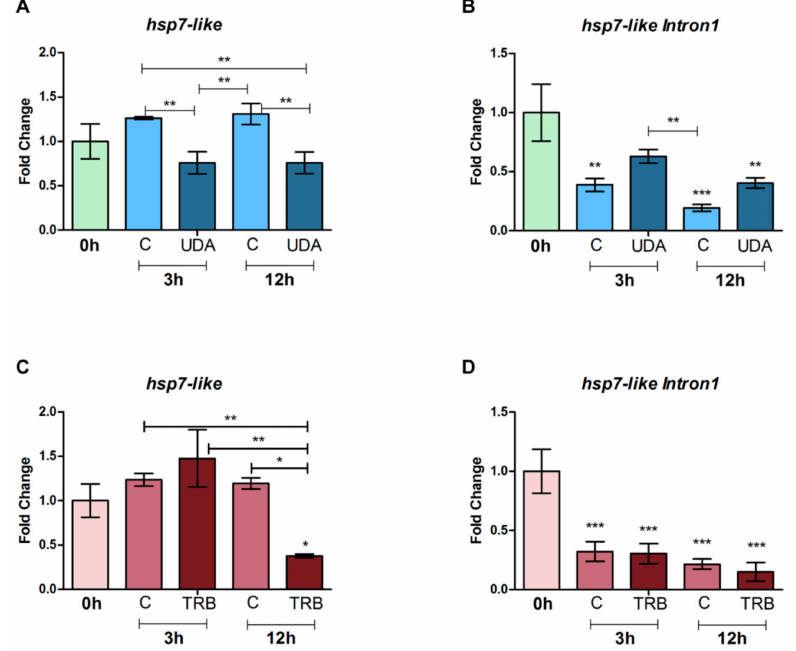
Figure 2. Intron1 retention after pre-mRNA processing of the hsp7-like gene visualized by electrophoresis following RT-PCR. T. rubrum was exposed to undecanoic acid (UDA) ( A ) and terbinafine (TRB) ( B ) for 0 h (control), 3 h, and 12 h. (M) Molecular weight ladder; (C + ) positive control; (C − ) negative control. The size of each amplicon was 153 bp for the processing of Intron1 and 241 bp for the retention of Intron1. The full-length gel is shown in Supplementary Figure S1.